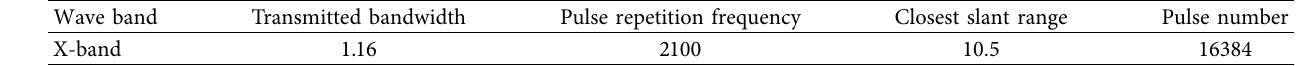
Table 1: Main parameters of the SAR